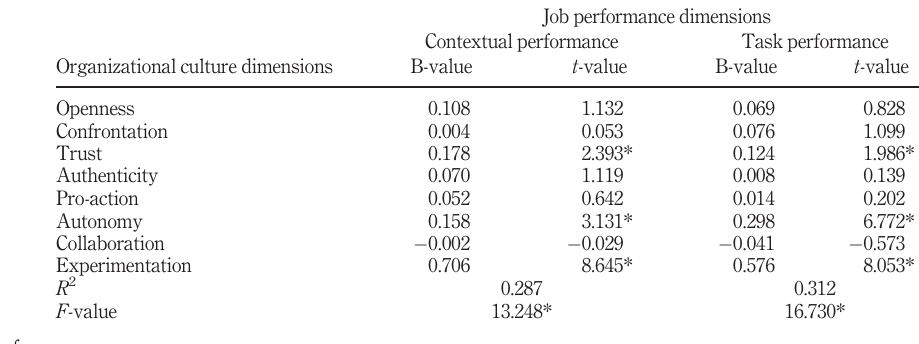
Table 2. Regression for organizational culture predictors for job